Question: Describe this figure in one sentence.
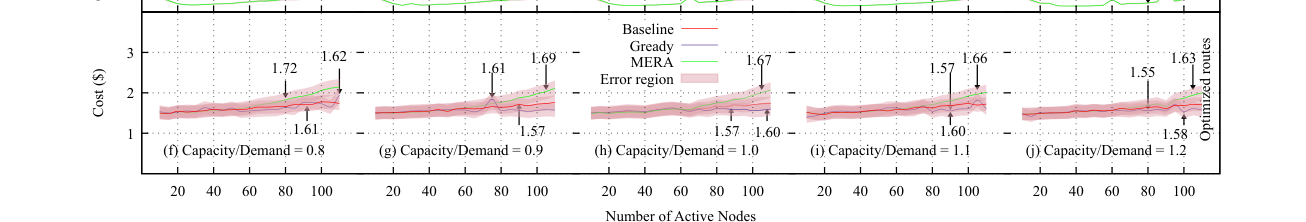
Answer: The influence of edge-to-cloud capacity and size on load dispersion and service provisioning cost: The increase in capacity reduces costs and converges them across all approaches, the increase in the number of active nodes increases utilization variation in all methods.